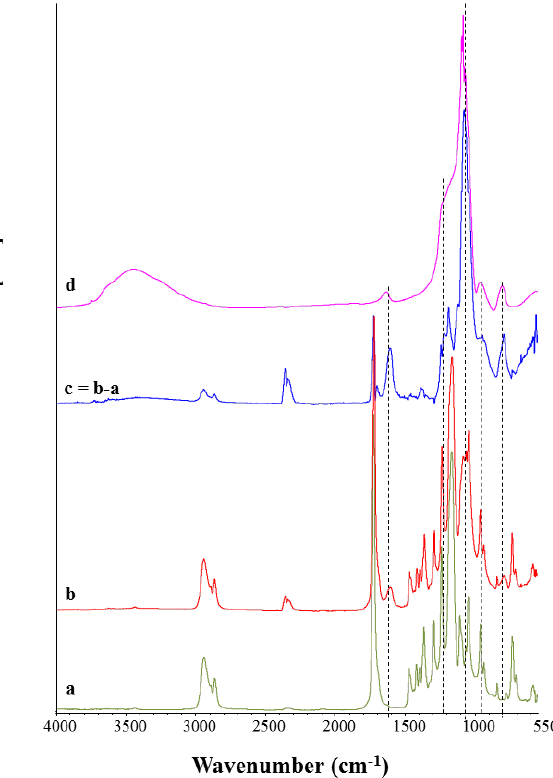
Figure 8. ATR-FTIR spectra of neat PCL electrospun fibers ( a ), PCL_Ca_MCM-41 composite electrospun fibers ( b ), the subtraction spectrum (neat PCL fibers subtracted from the composite fiber spectrum, ( c ) and the Ca_MCM-41 particle spectrum ( d ). Peaks of relevance are discussed in the text.